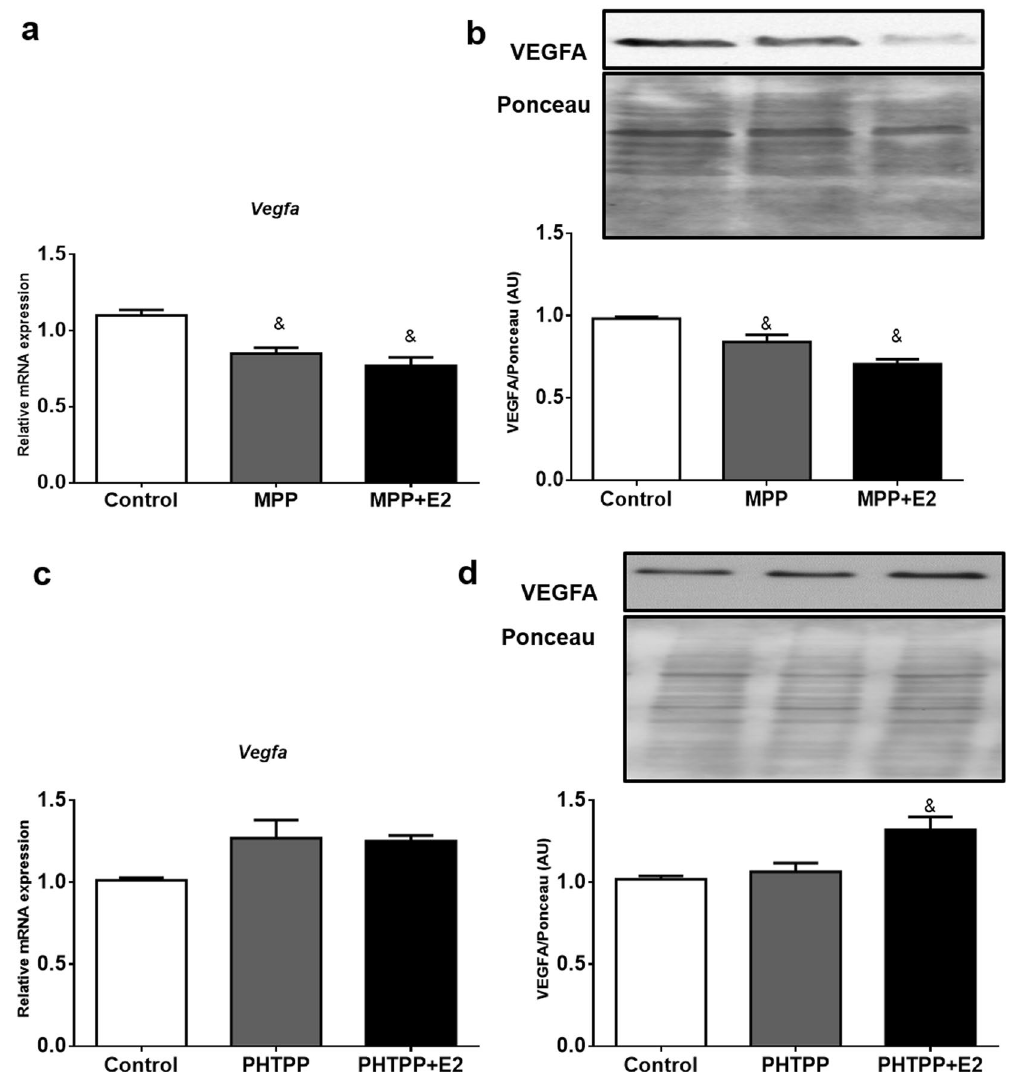
Figure 4. Effects of ESR1 antagonist (MPP) and ESR2 antagonist (PHTPP) on VEGFA mRNA and protein: 3T3-L1 adipocytes were treated for 24 hours with 10 µ mol/L of MPP ( a , b ) or 100 nmol/L of PHTPP ( c , d ), in the absence or presence of 10 nM of E2. Full-length blots of these cropped images are presented in Supplementary Figure S1. Cells treated with vehicle (0.1% DMSO) were used as control. The representative autoradiograms are shown on top. Data are shown as the mean ± SEM of 6 samples. & P < 0.05 vs